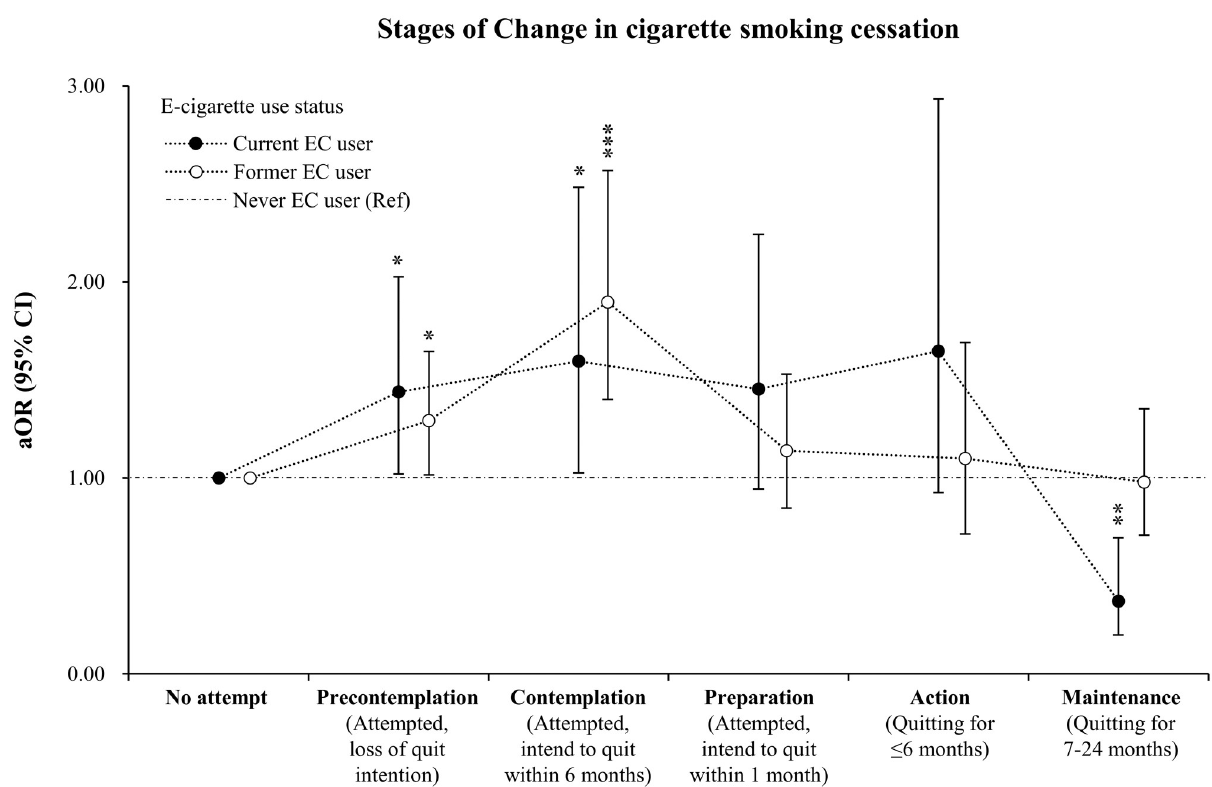
Fig 3. Odds ratio for the stages of change in cigarette smoking cessation by e-cigarette use status. Dots represent odds ratio and horizontal lines represent 95% confidence intervals. � P < 0.05; �� P < 0.01; ��� P < 0.001; aOR = adjusted odds ratio; CI = confidence interval; EC = e-cigarette; Ref =